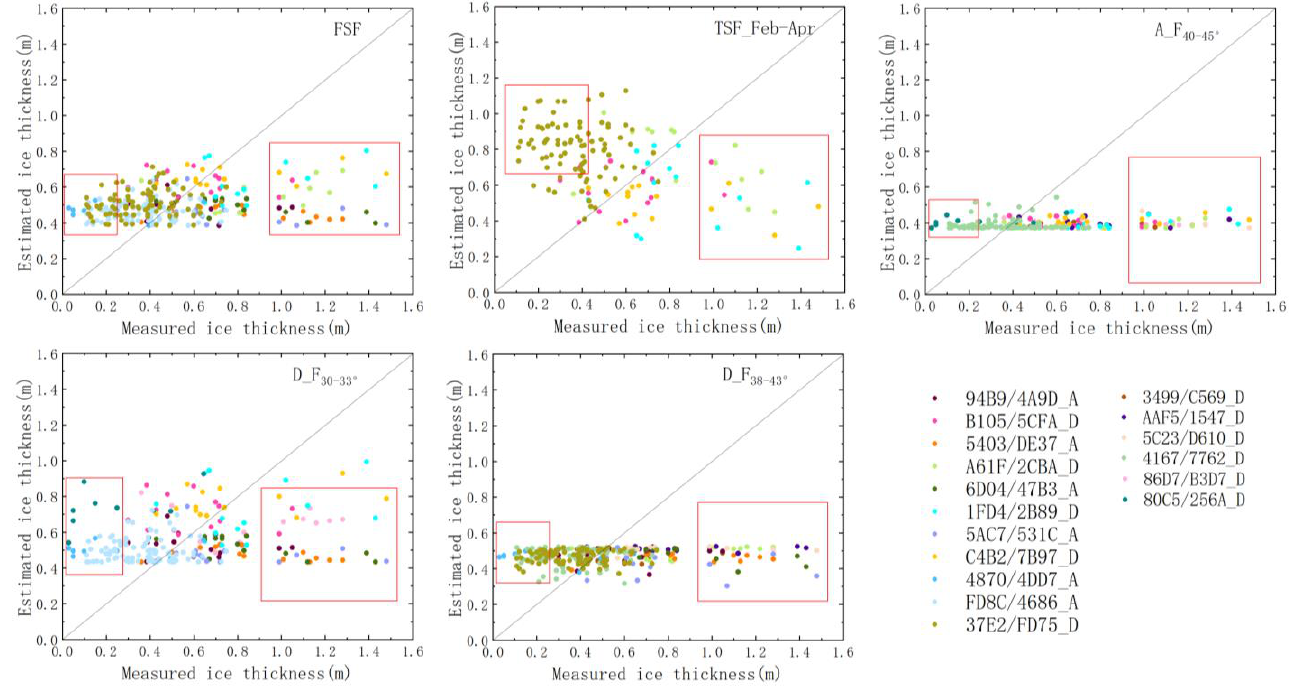
Figure 13. Analysis of the applicability of the Binggou River schemes. For example, 94B9/4A9D_A in the figure legend, 4A9D indicates the image name, and A indicates an ascending orbit (refer to Figure 3).